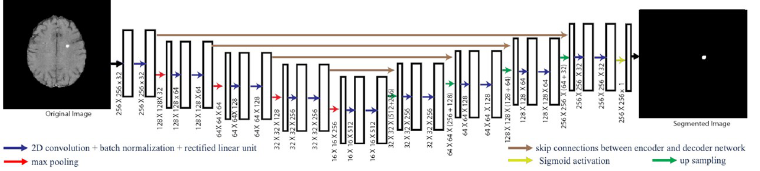
Fig 1. UNet architecture. The model has five depths of encoder and decoder. Blue arrows represent 2D convolution layers with batch normalization and rectified linear unit, red arrows represent max pooling layers, and green arrows represent up sampling layers. Brown arrows are skip connections between the encoder and decoder networks. MRI contrasts and probability maps are the input, and the segmented lesion map is the output.